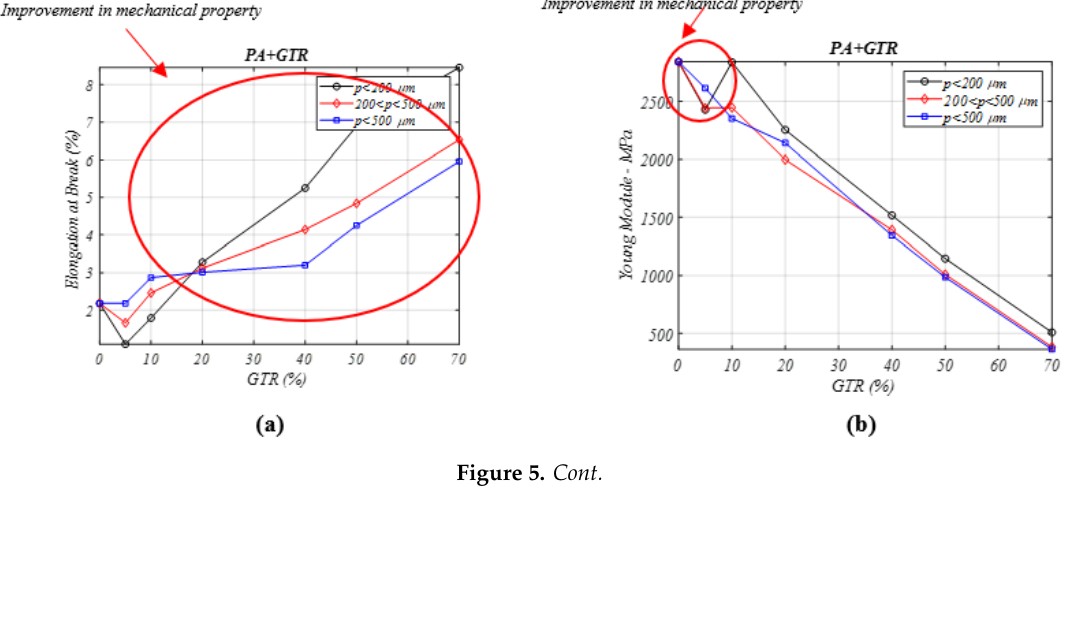
Figure 5. Mechanical properties analysis for different percentages of PA/GTR composites and particle diameters: ( a ) elongation at break (%), ( b ) Young ’s modulus (MPa), ( c ) toughness (J) ( d ) tensile stress (MPa). In Figure 5b the Young ’s modulus of the PA/GTR composites is analyzed. Its value decreases as larger amounts of GTR is incorporated as a reinforcement, comparing to PA with no GTR. For low GTR concentrations (5% GTR), the stiffness remains similar to that of neat PA (2818 MPa (PA) vs. 2715 MPa (PA